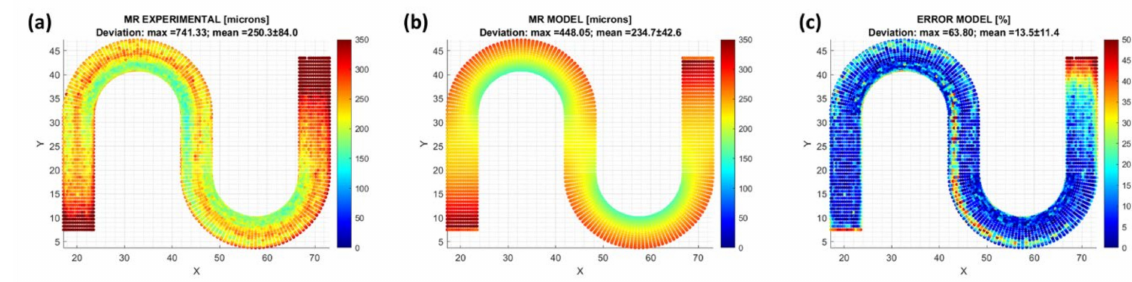
Figure 20. S-shape MR t fields after 26 AFM passes: ( a ) experiment; ( b ) modelling, ( c ) experiment vs. modelling error.